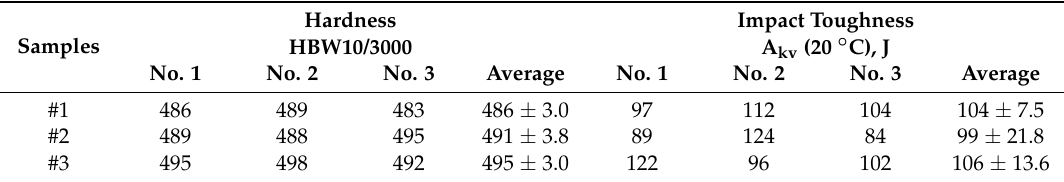
Table 3. The mechanical properties of the base